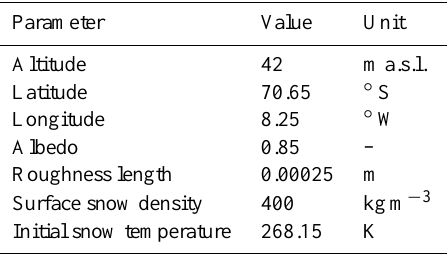
Table 1. Overview of geographical and land surface parameters at Neumayer in